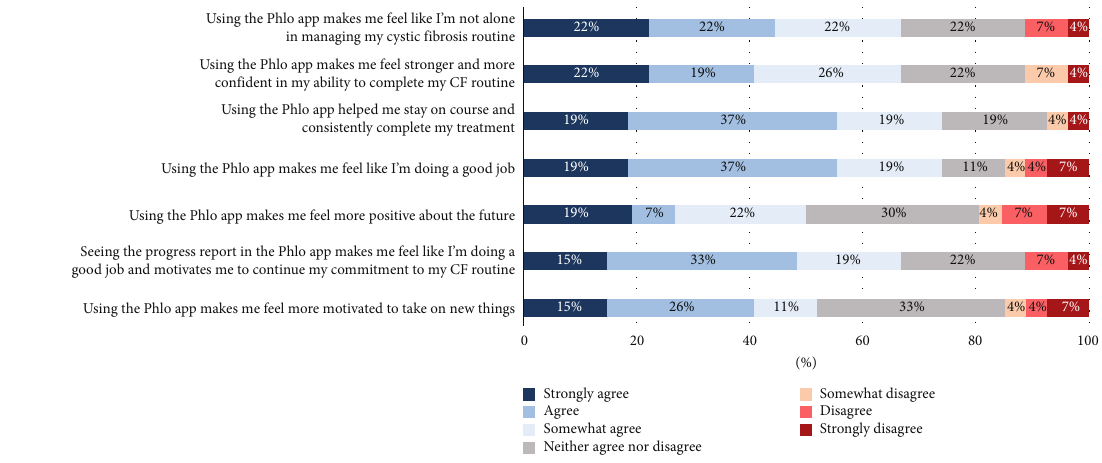
Figure 2: Patients ’ self-evaluation of the app ’ s e ff ect on their con fi dence and motivation. Table 4: Healthcare resource utilization ( N = 28